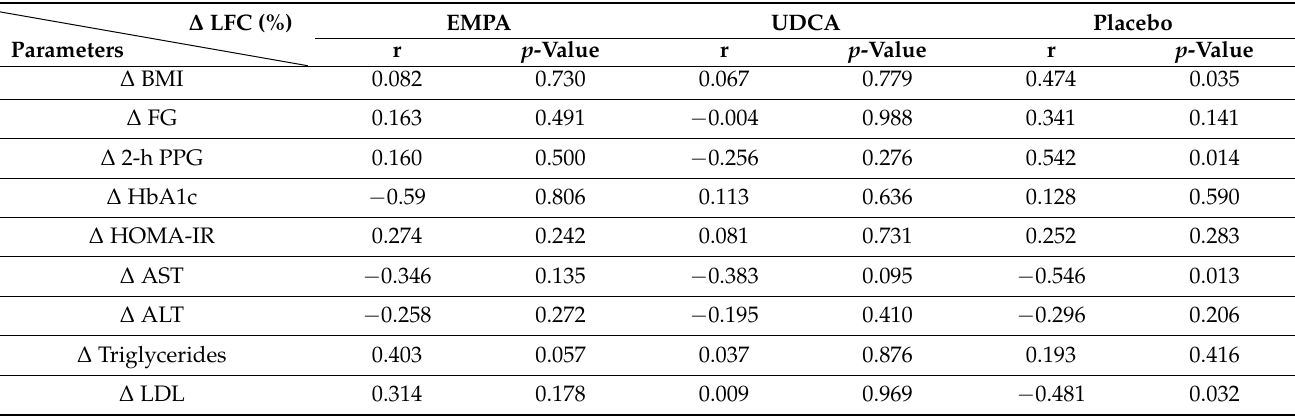
Table 3. Correlation study between changes in LFC (%) and changes in selected measured parame- ters after six months of treatment in study groups.